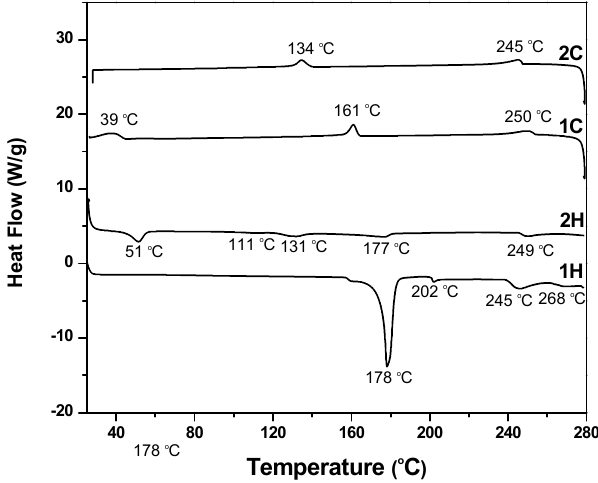
Figure 5. DSC thermograms of V9 obtained at heating and cooling rates of 10 °C/min in nitrogen.